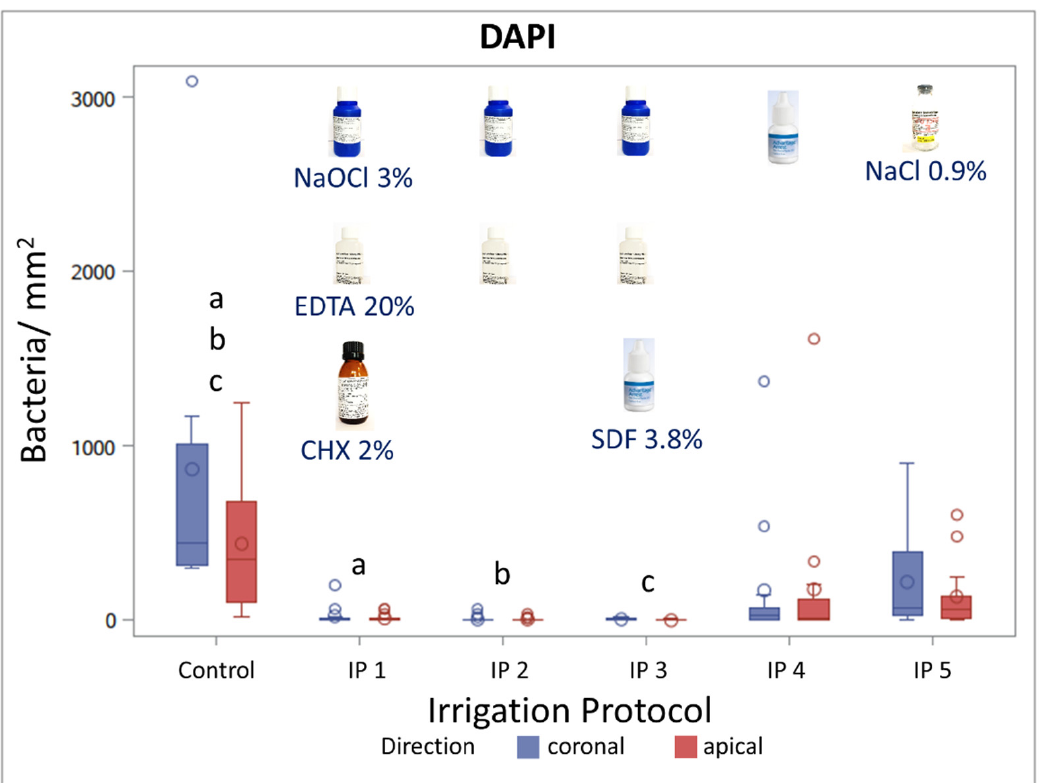
(Figure 3). Overall, the quantification of the bacterial colonization in the root dentin slices microscopically after DAPI staining, as well as the bacterial quantification of the complete root dentin with qPCR, led to comparable results (Figures 2 and 3). Representative root canal sections of DAPI-stained fluorescent microscopical images of the bacterial load and distribution within the dentinal tubules of the control group IP 0 and after the application of the different irrigation protocols (IP 1–5) is depicted in Figure 4. Bacterial infection in the dentinal tubules was mainly detected in the control group and to some extent in the irrigation protocols IP 4 and IP 5, while in IP 1, IP 2, and IP 3, almost no bacteria were detected. Additionally, IP 4 and IP 5 showed a reduction of the bacterial load in the dentinal tubules close to the root canal lumen, most likely due to ultrasonic agitation with the non-anti-microbial irrigant NaCl 0.9 %. In contrast, the control group displayed a bacterial colonization on the root canal surface, as well as in the dentinal tubules close and distant to the root canal lumen.